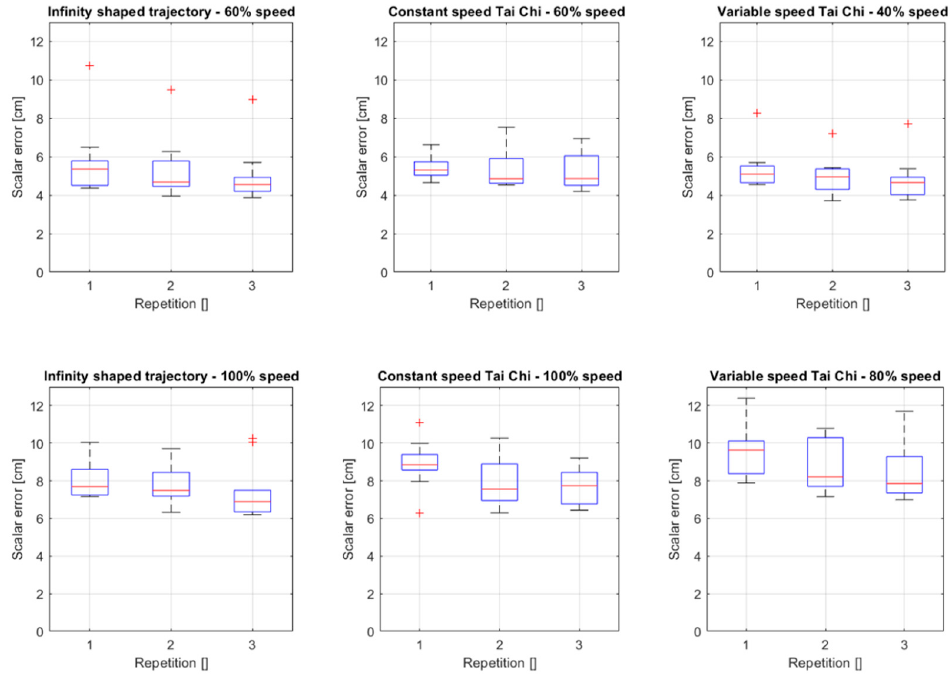
Figure 6. Boxplots of the scalar error over the repetitions for each target profile and speed.